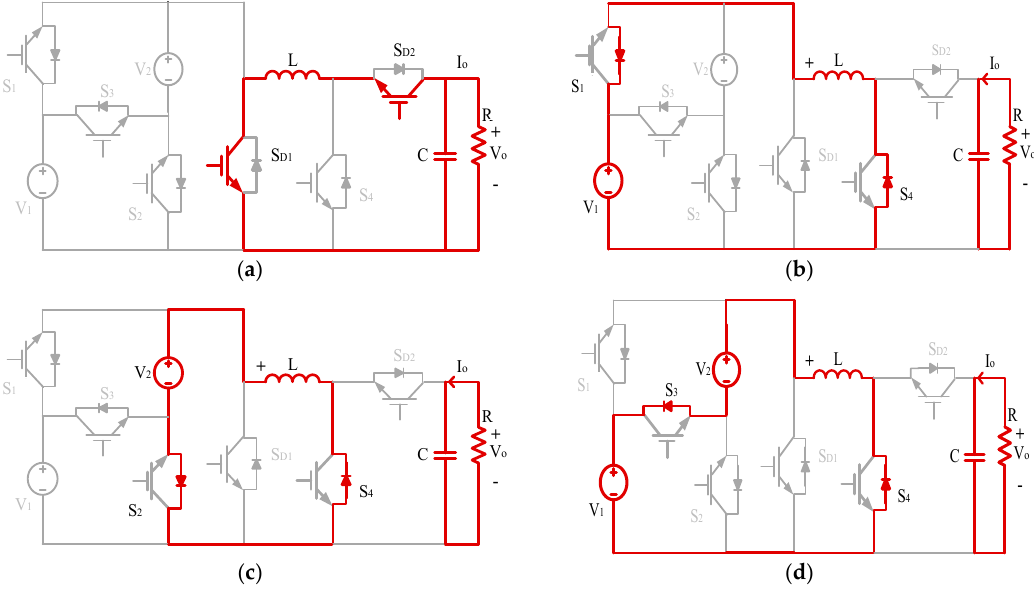
Figure 4. Different working states in bidirectional mode: ( a ) inductor charging; ( b ) Source 1 charging; ( c ) Source 2 charging; and ( d ) simultaneous charging of sources.